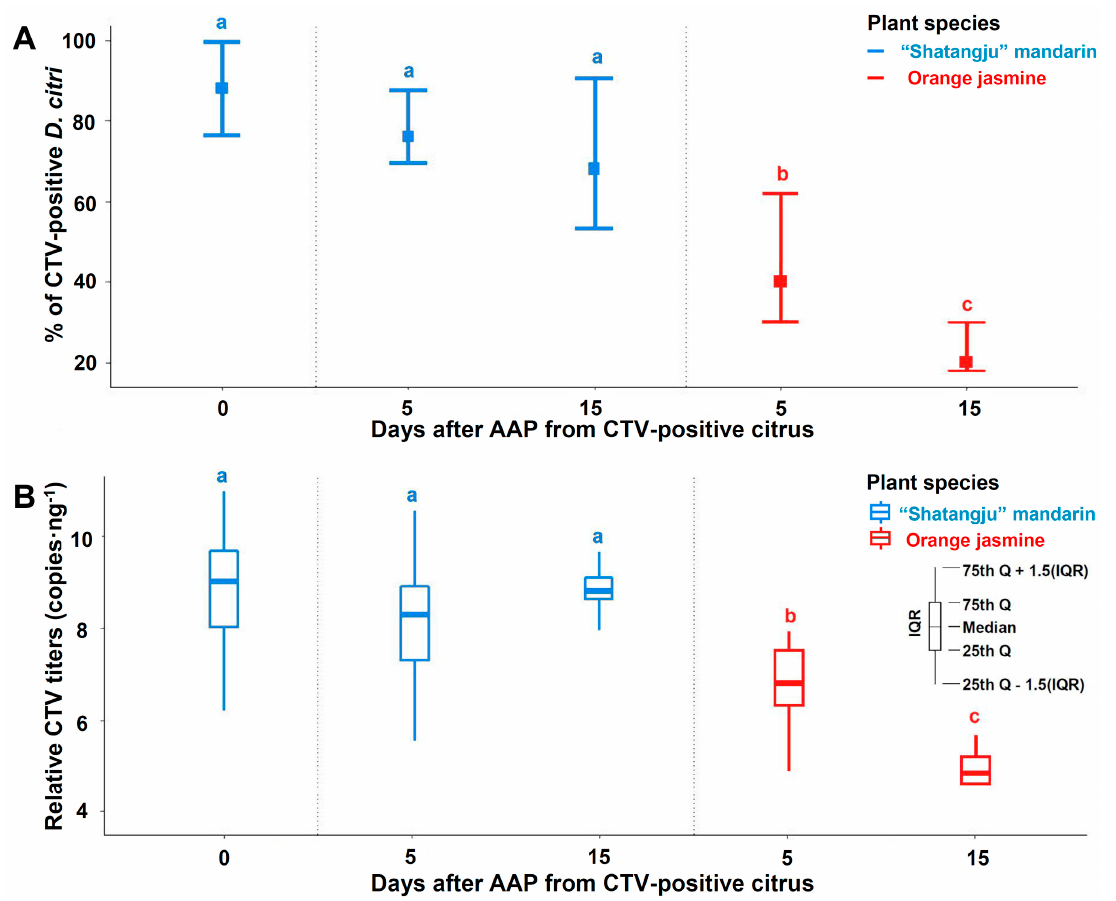
Figure 3. Persistence period of Citrus tristeza virus (CTV) in Diaphorina citri on different host plant species, as detected by RT ‐ qPCR. ( A ) Incidence of CTV ‐ positive D. citri ; each treatment (N = 12 or 8 plants) contained 10 D. citri . The same letter indicates no significant difference by non ‐ parametric Kruskal–Wallis. ( B ) Box plots of obtained relative titers of CTV in total extracted cDNA (i.e., log ‐ transformed copy numbers of the CTV p20 gene in D. citri cDNA). Non ‐ overlapping error bars between the box plots indicate statistical significance. Legend: “Shatangju” mandarin: C itrus reticulata Blanco “Shatangju”; orange jasmine: Murraya paniculata (L.) Jack.; AAP: acquisition access period; Q = percentile; IQR = interquartile range; 0 day: testing the psyllids immediately after the end of AAP.